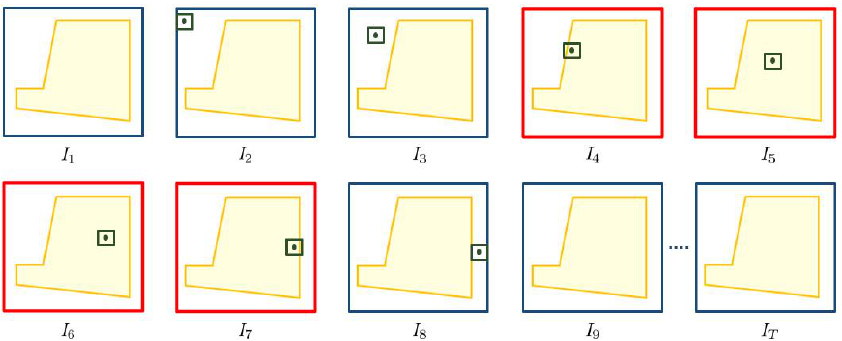
Figure 5. Illustration of an intrusion event caused by a single object. Video with T frames, where S na is shown with yellow surface and object with a green bounding box plus center. The object causes an intrusion event for four frames from frame I 4 to I 7 , colored in red.